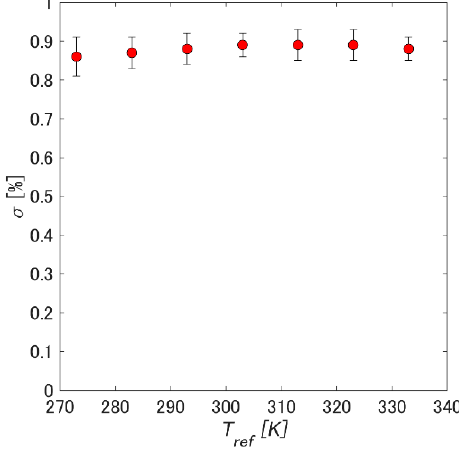
Figure 8. Pressure sensitivity, σ, under varying the reference temperature, T ref .